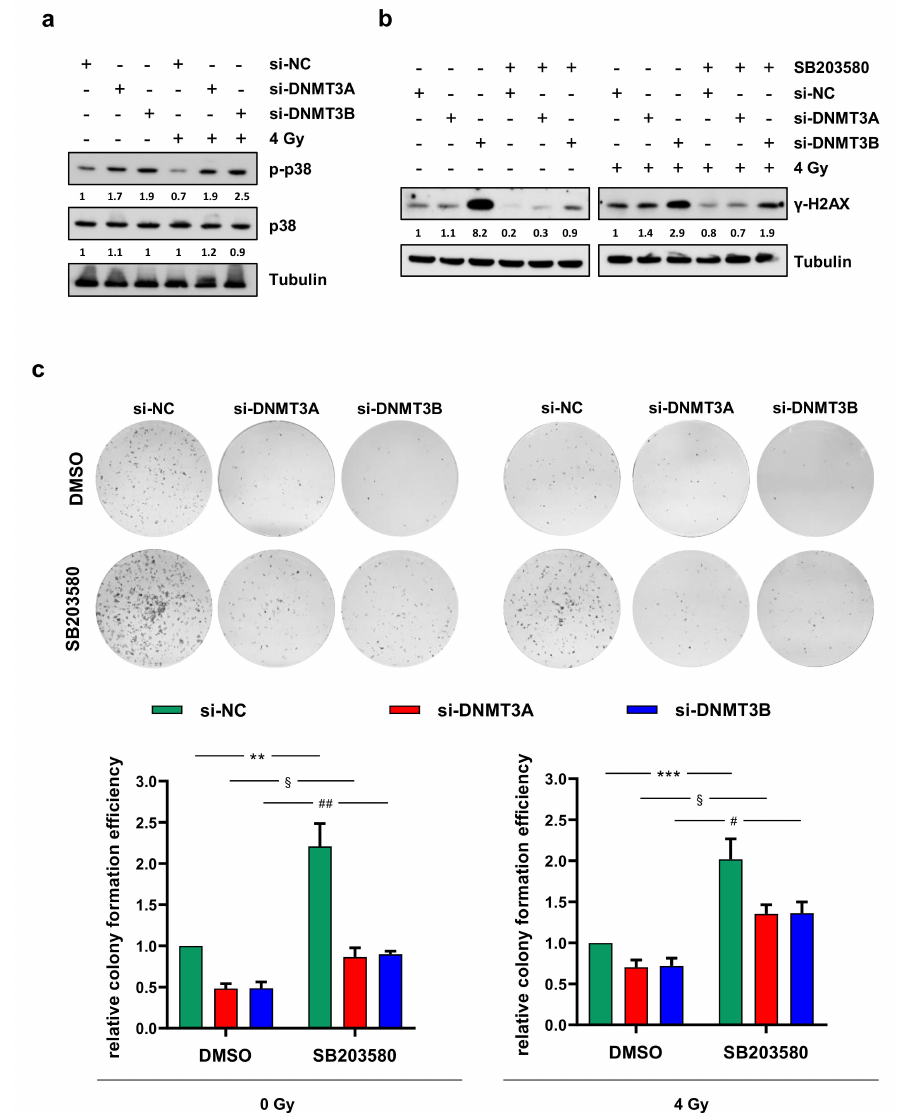
Figure 5. p38 inhibition counteracts γ -H2AX up-regulation and the reduced clonogenic ability induced by DNMT3A/3B silencing. ( a ) Western blotting showing the increase of phosphorylated p38 (p-p38) in RD cells at 24 h upon irradiation and 72 h after DNMT3A or DNMT3B knocking down. Levels of total p38 was not perturbed by the specific siRNA transfection and/or irradiation. Tubulin expression was used as loading control. ( b ) Western blotting showing γ -H2AX levels in RD cells pre-treated with SB203580 or DMSO, transfected with si-DNMT3A, si-DNMT3B or si-NC, and exposed or not to radiation. Tubulin expression was used as internal control. ( c ) RD cells at 24 h after irradiation were seeded at low density and allowed to grow for 10 days. Representative images of colonies stained with crystal violet. Bars represent means ± SD of three independent experiments, each performed in triplicate. Colony forming efficiency, calculated by crystal violet absorbance, was expressed as fold increase over si-NC/DMSO/0 Gy (left panel) and si-NC/DMSO/4 Gy (right panel) arbitrarily set at 1. Statistical analyses were performed by using two-way ANOVA: **, p < 0.01, vs. si-NC/DMSO/0 Gy; §, p < 0.05 vs. si-DNMT3A/DMSO/0 Gy; ##, p < 0.01 vs. si-DNMT3B/DMSO/0 Gy (left panel); ***, p < 0.001, vs. si-NC/DMSO/4 Gy; §, p < 0.05 vs. si-DNMT3A/DMSO/4 Gy; #, p < 0.05 vs. si-DNMT3B/DMSO/4 Gy (right panel). Figure S1f,g presents the densitometric analyses of the different experiments performed and the corresponding statistical